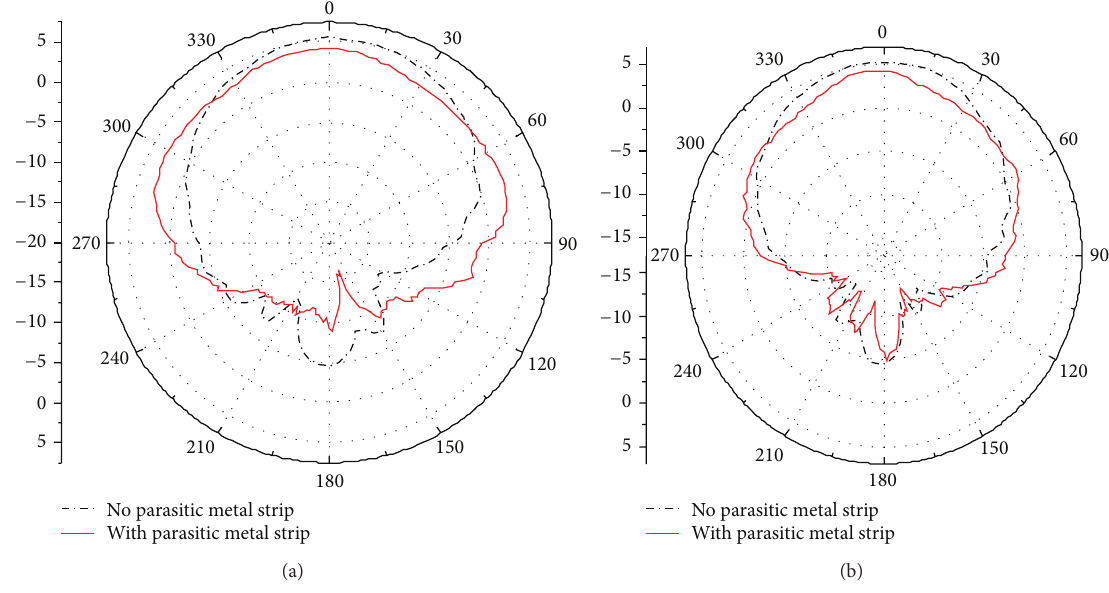
Figure 6: 2D patterns in 𝑥 - 𝑧 plane of the proposed dual-band CP antenna: (a) L1 band, (b) L2 band.